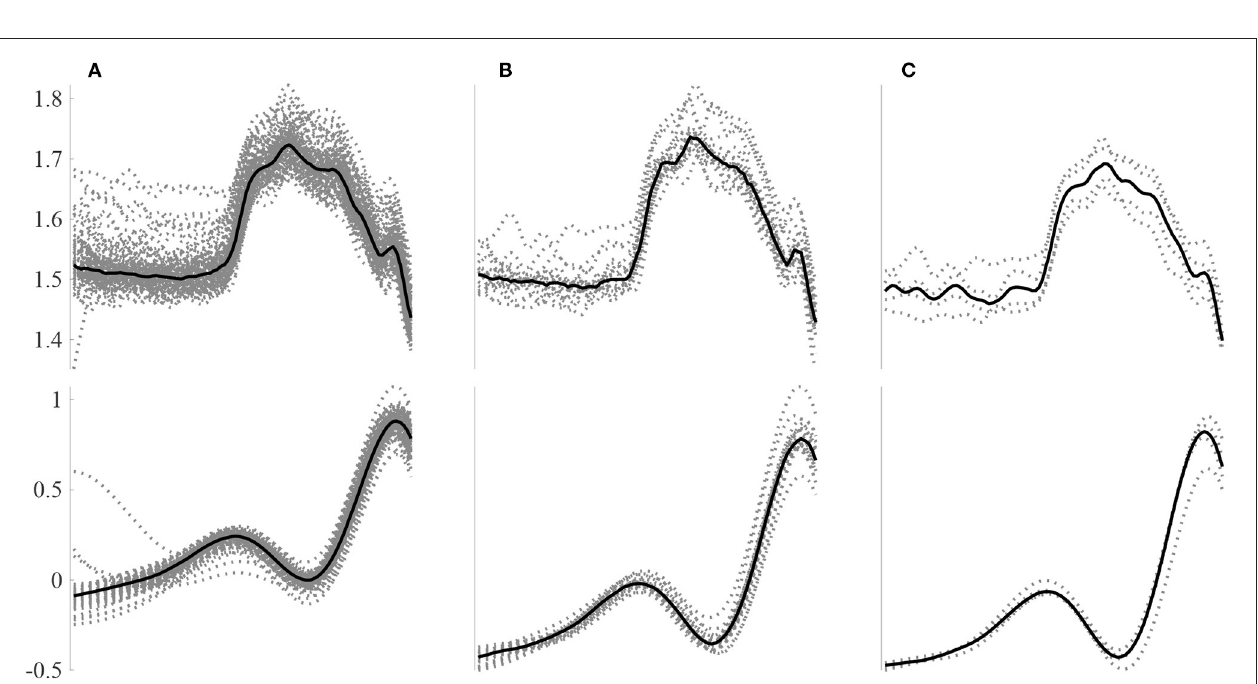
FIGURE 2 | Example P-wave intra-patient models built using a different number of surrounding beats for the raw signal (top) and the W 4 s ( l ) DWT decomposition. Intra-patient models built using (A) 80, (B) 20, and (C) 4 beats.